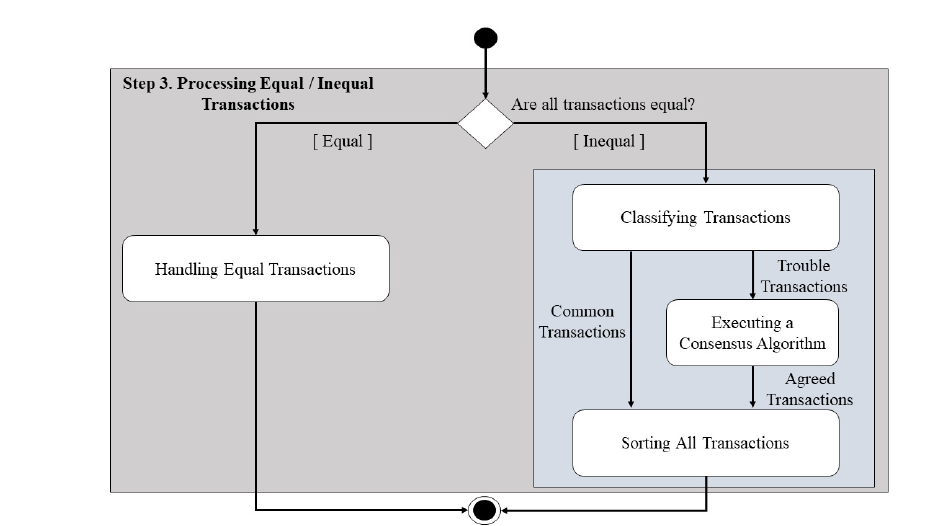
Figure 3. Steps for processing collected